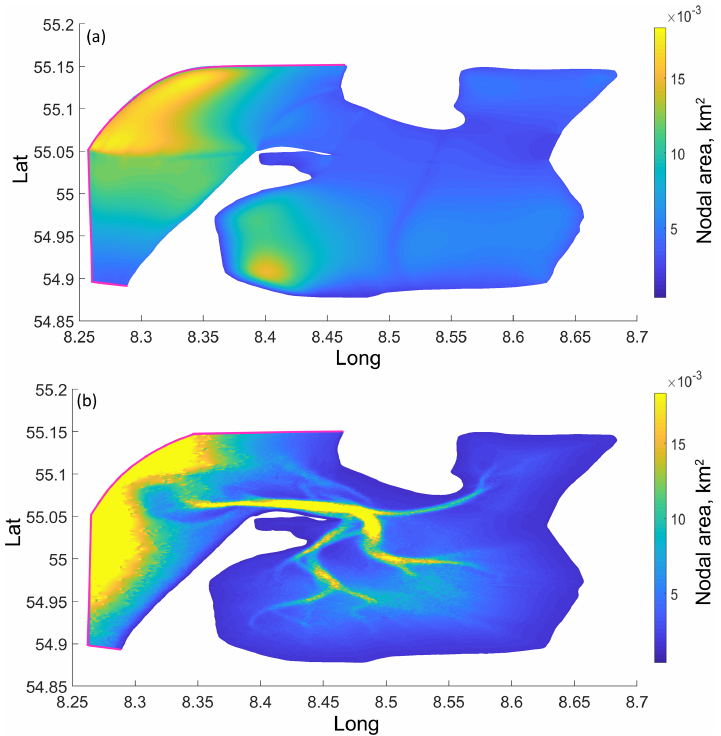
Figure A1. Nodal area where the pink colour indicates the position of the open boundary: (a) curvilinear grid and (b) unstructured grid.